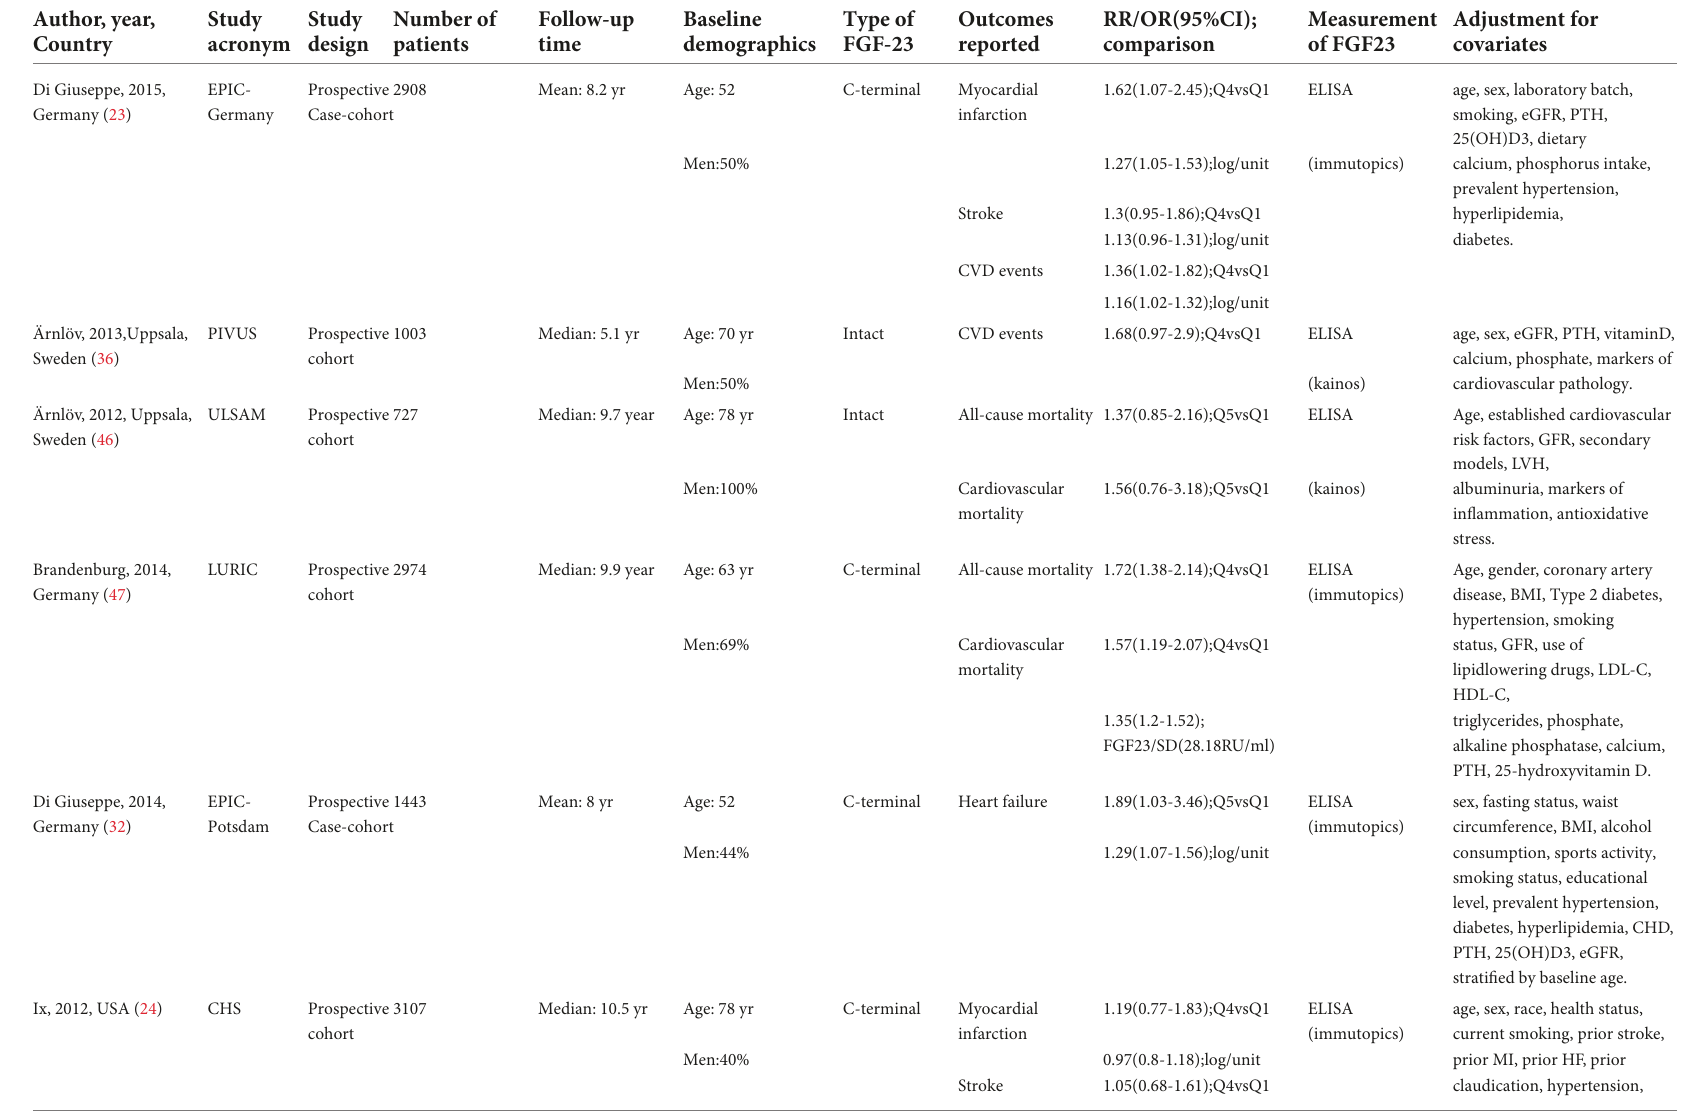
TABLE 1 Basic characteristics of the articles included in this systematic review and meta-analysis of FGF23 and the risk of cardiovascular diseases and mortality in the general